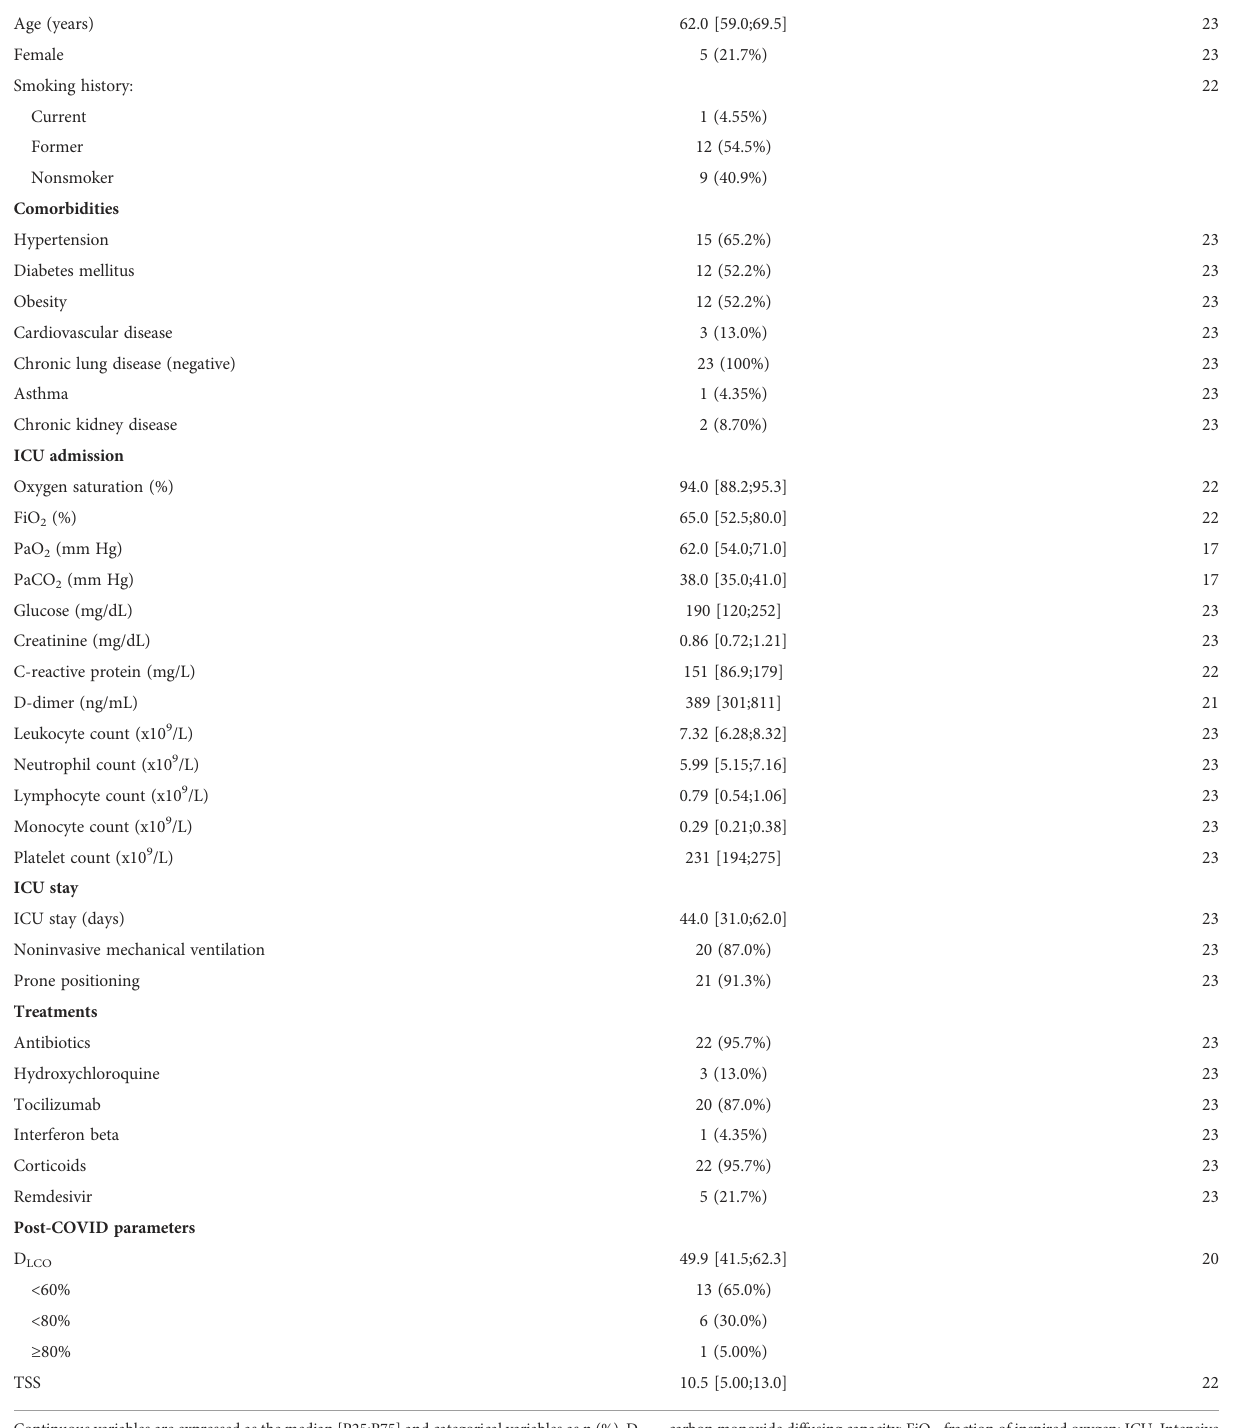
TABLE 3 Characteristics of post-Covid patients (study population